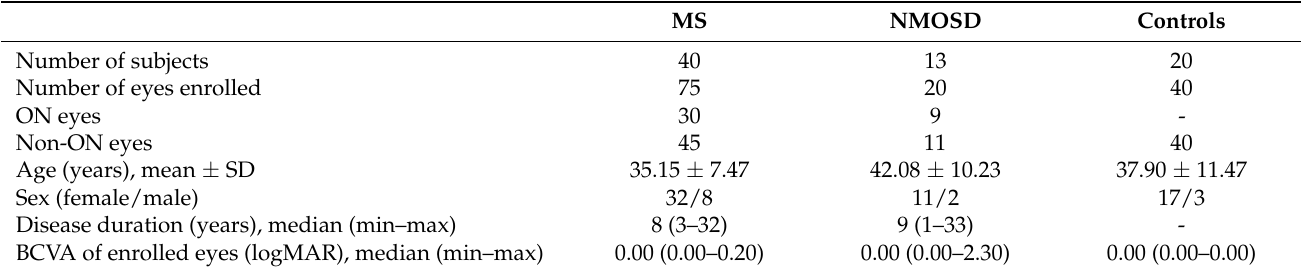
Table 1. Demographic and clinical characteristics of MS, NMOSD patients, and